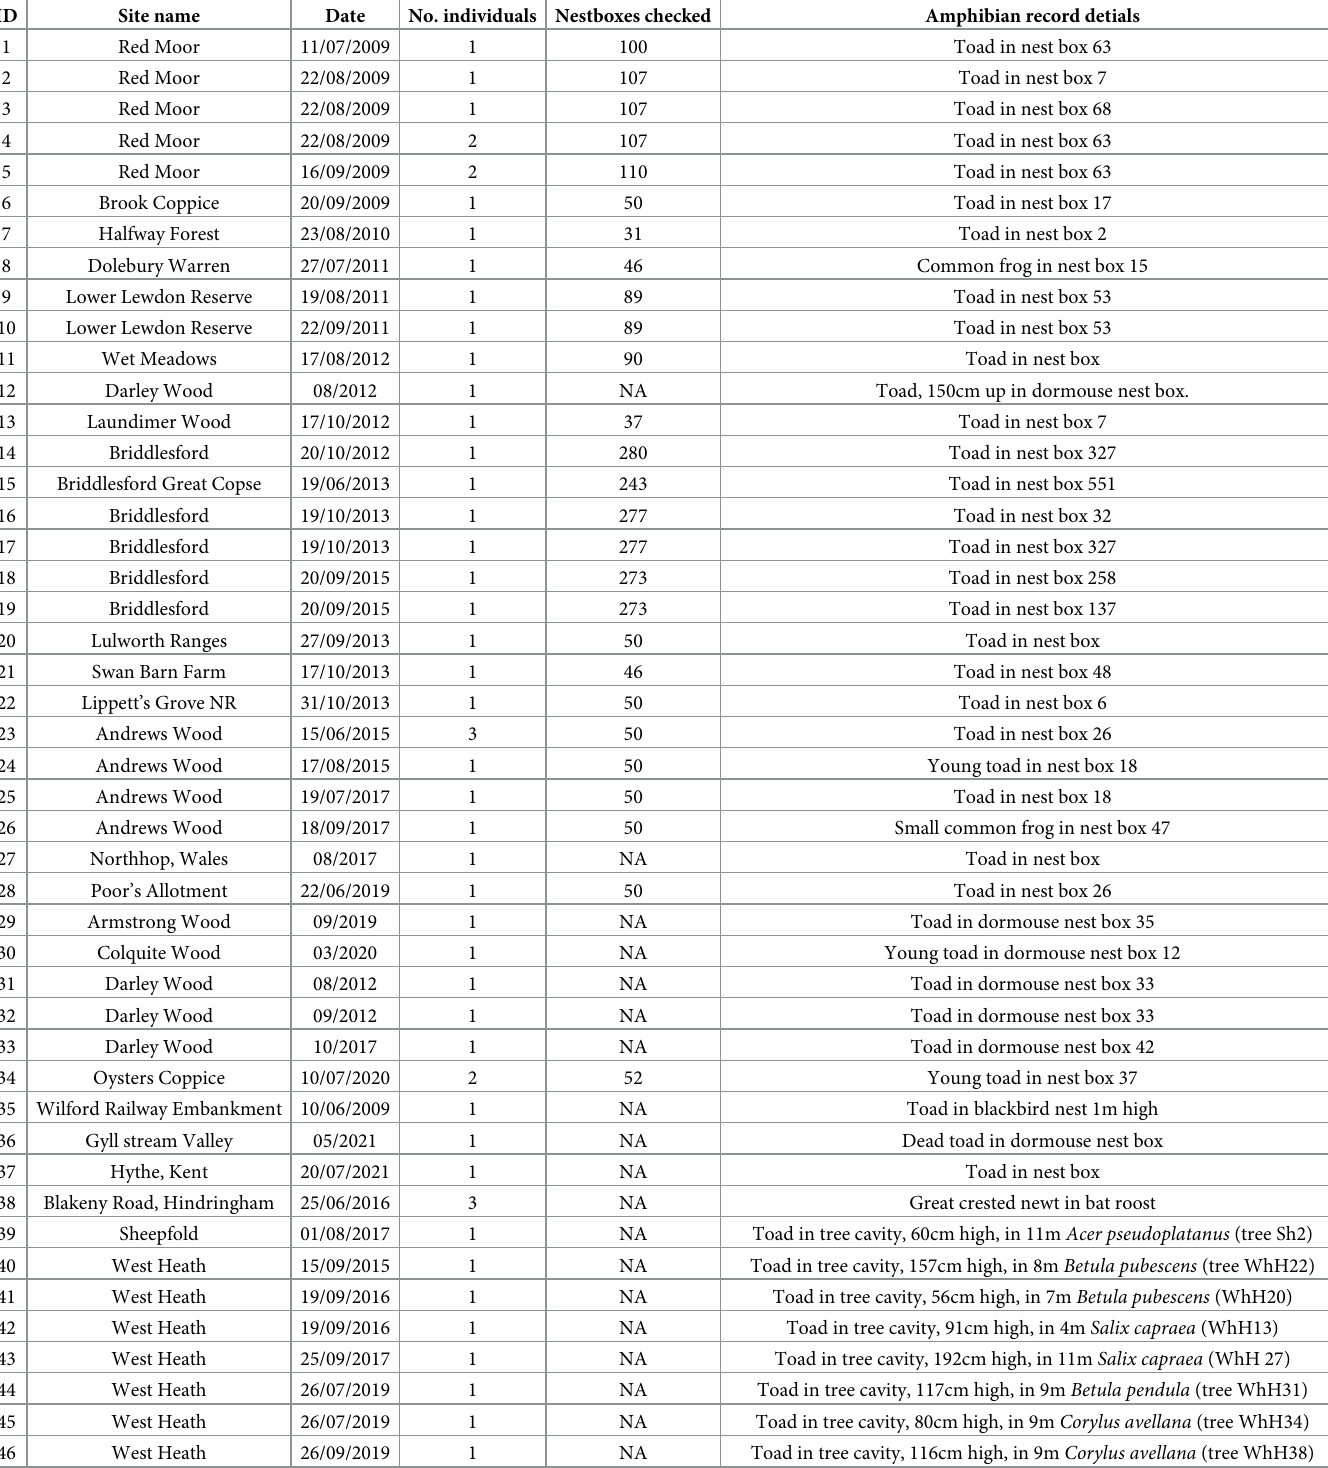
Table 2. Amphibian records in nest boxes or tree cavities collated from the various survey schemes for arboreal mammals. Note that in some cases amphibians were 20-45cm higher inside the PRF. NA- Not available.